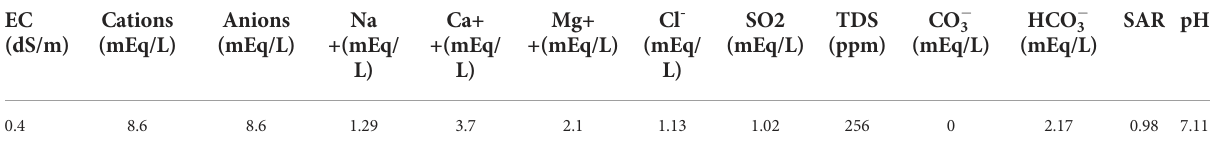
TABLE 1 Chemical properties of irrigation